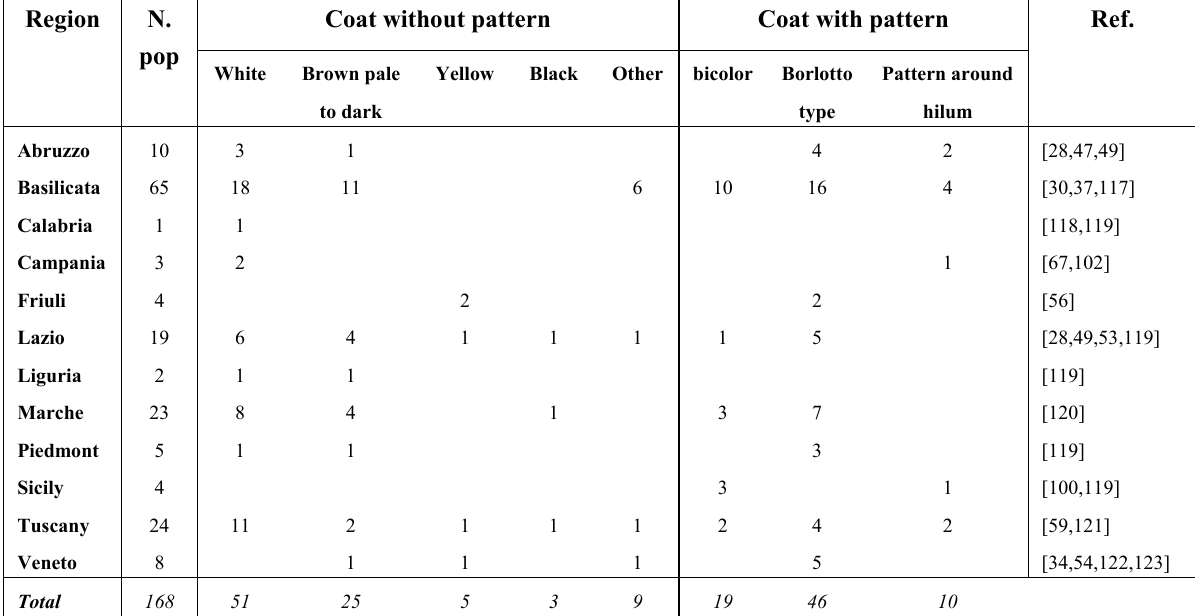
Table 2. Distribution of the seed coat types (according to IBPGR) within Italian common bean landraces as described in the